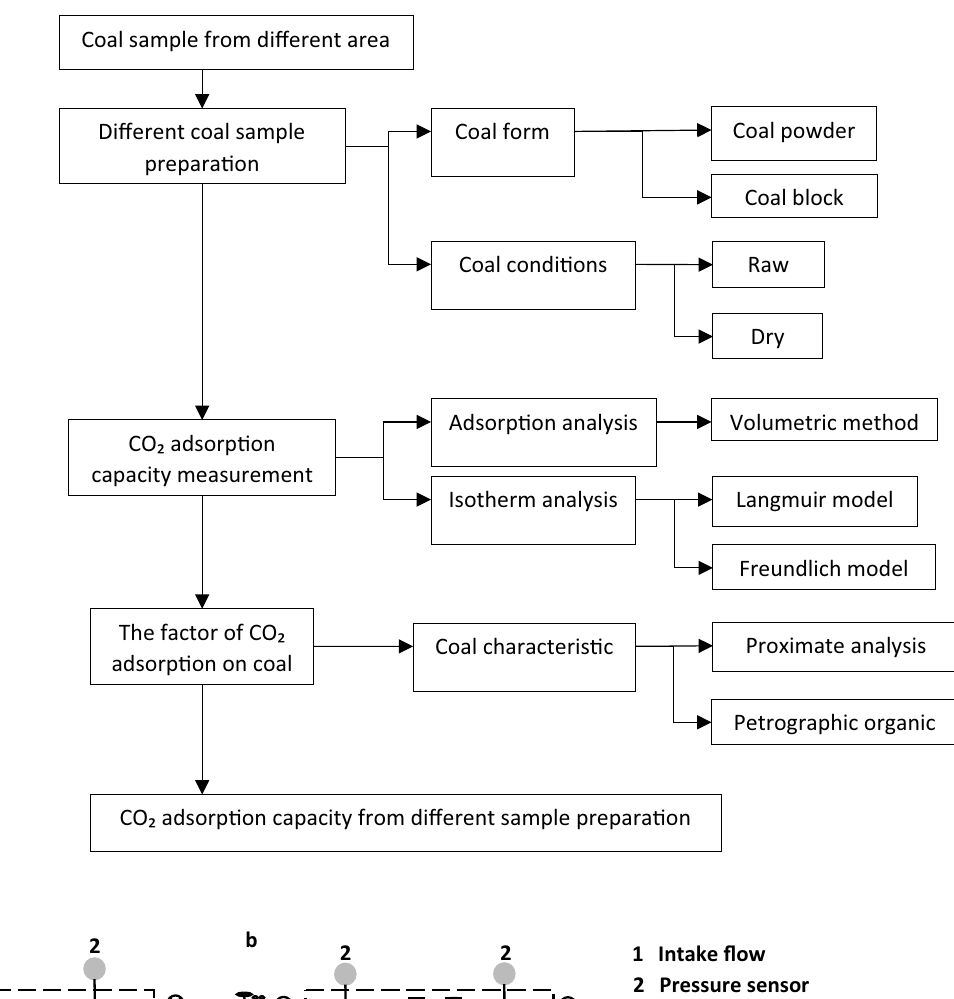
Fig. 4 Flowchart of experimen- tal process in this study